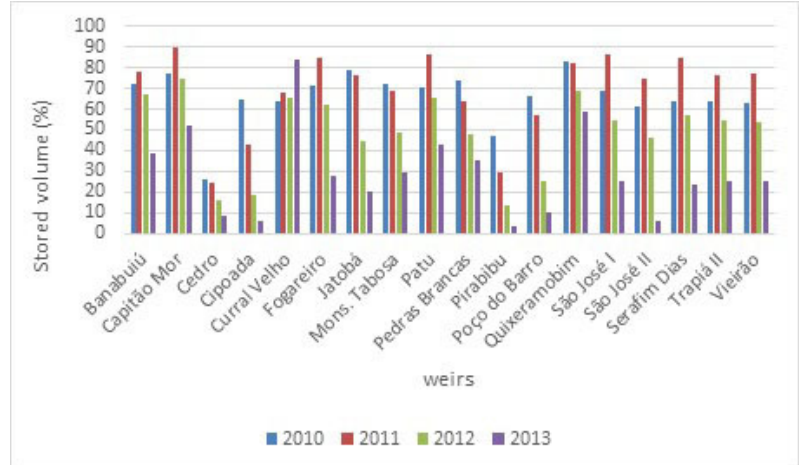
Figure 2. Average annual volume of the weirs of the Banabuiú Basin (2010 to 2013). Source: Cogerh,